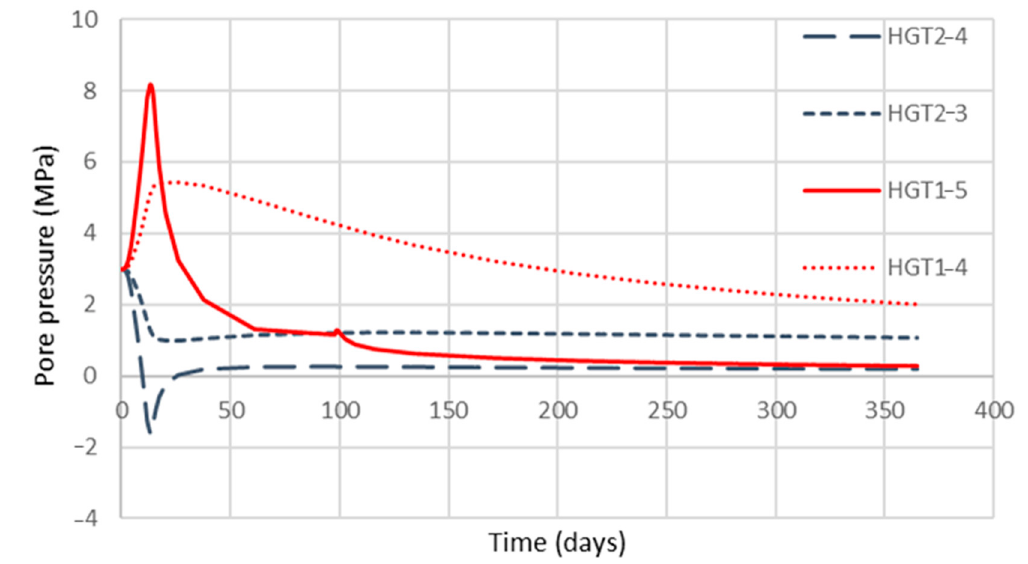
Figure 17. Simulated pore pressure evolution.